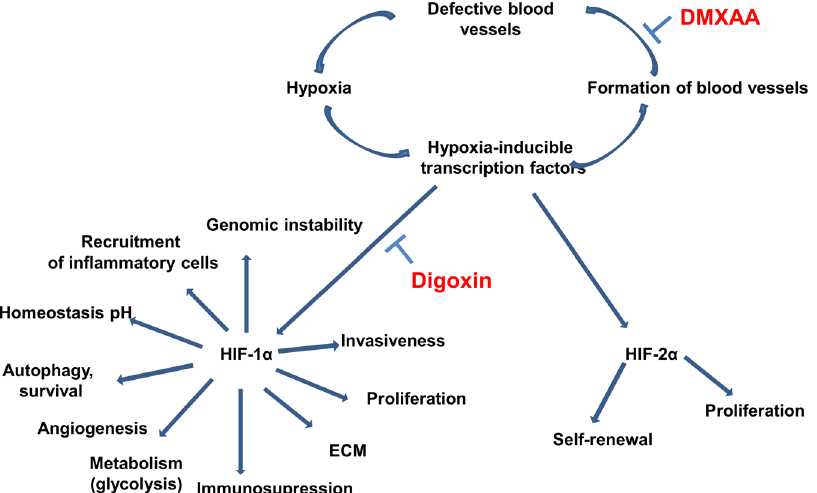
Figure 7. Scheme of action of the drugs. DMXAA administration to mice bearing tumors leads to the destruction of existing tumor blood vessels. Destruction of the vessels results in the formation of hypoxia areas where HIF-1 α transcription factor expression is increased. Activation of HIF-1 α triggers several mechanisms that promote tumor growth. Inhibition of HIF-1 α after digoxin administration supresses tumor